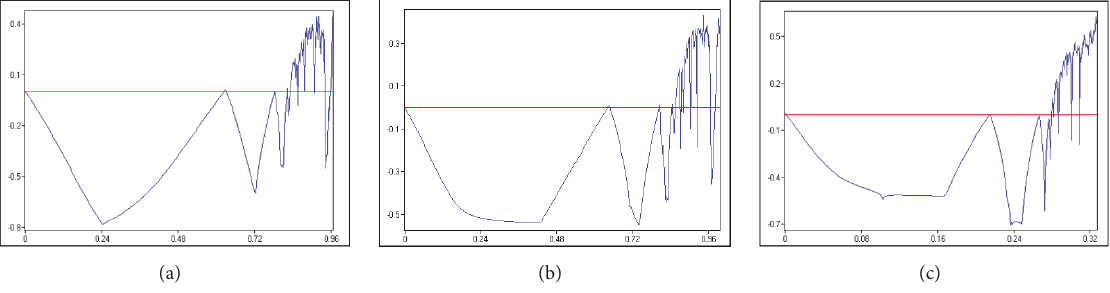
Figure 5: (a) The LLE as 𝛼 changes. (b) The LLE as 𝛽 changes. (c) The LLE as 𝛾 changes.